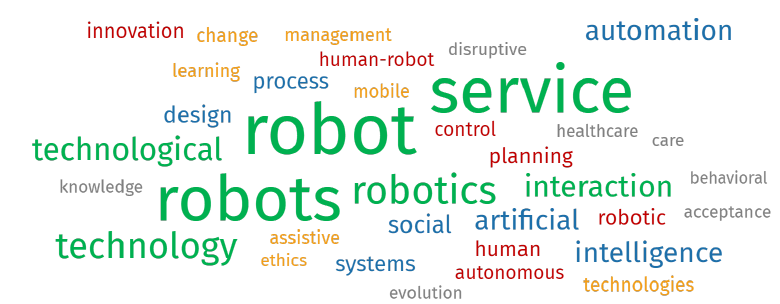
Figure 7. Word cloud of simple keywords used by authors in the reviewed literature.